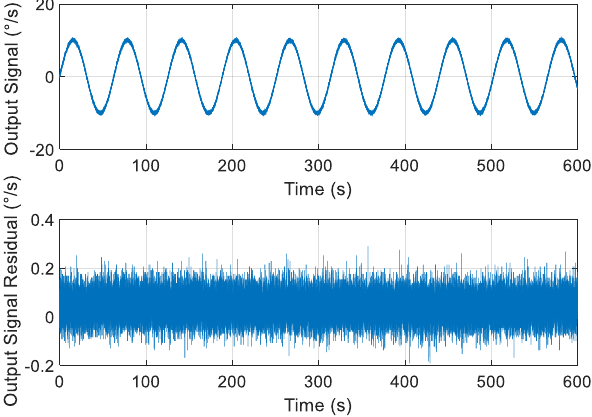
Figure 7. The output signal and residual value of a single gyro.